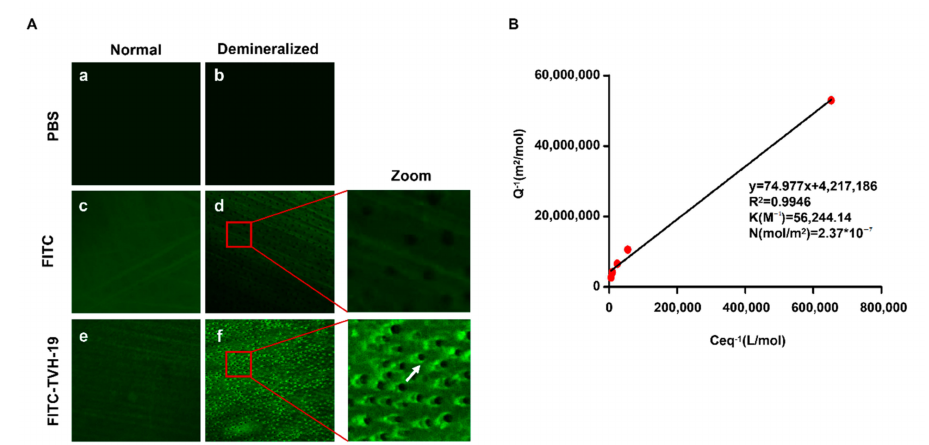
Figure 2. Adsorption capability of peptide on dentin surface and HA. ( A ) shows CLSM images of sound dentin surface ( Aa ), non-treated demineralized dentin sample surface ( Ab ), FITC-treated normal dentin surface ( Ac ), FITC-treated deminer- alized dentin surface ( Ad ), FITC-labelled TVH19-treated normal dentin surface ( Ae ) and FITC-labelled TVH-19-treated demineralized dentin surface ( Af ). The arrow shows that the FITC-labelled TVH19 accumulated on the peritubular dentin. ( B ) Shows the Langmuir adsorption curve of TVH19 to HA. R 2 is the correlation coefficient. The affinity of TVH-19 molecules for HA adsorption sites (K) and the maximum number of adsorption sites per gram of HA (N) were calculated from the best-fit regression